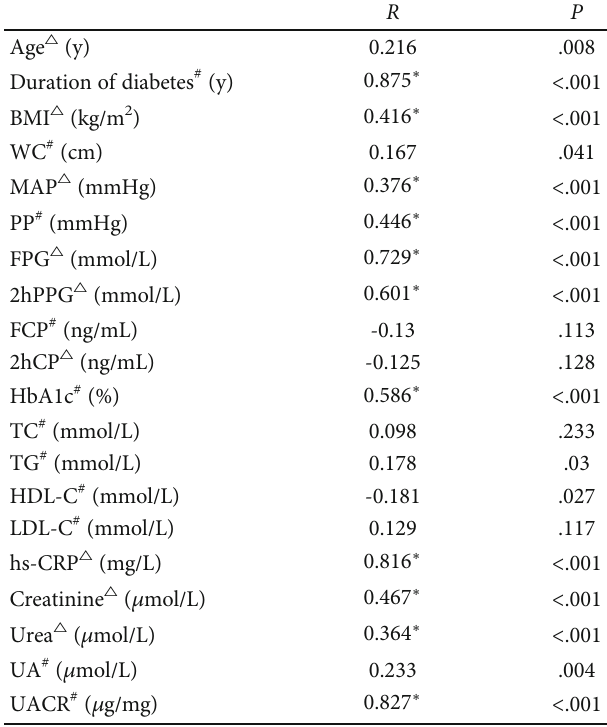
Table 2: Correlation analysis of baPWV and other